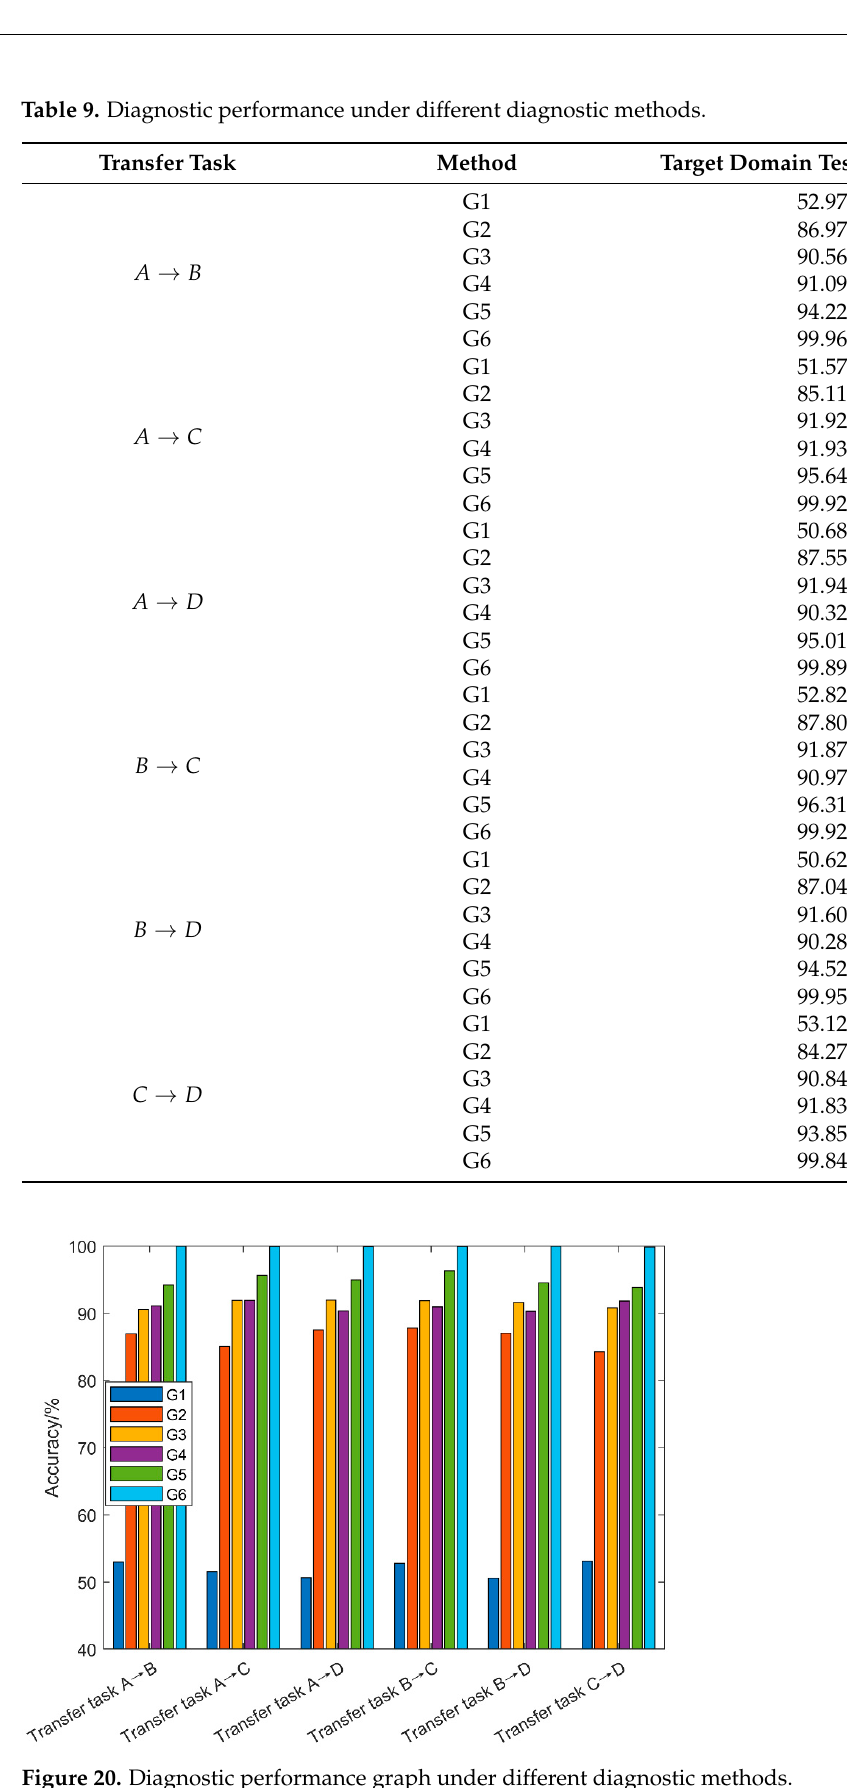
Figure 20. Diagnostic performance graph under different diagnostic methods.